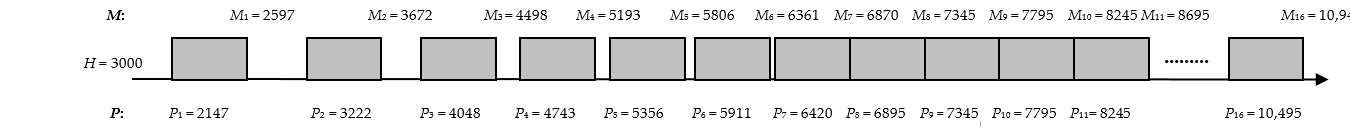
Figure 3. Moments M n and P n (authors’ figure).